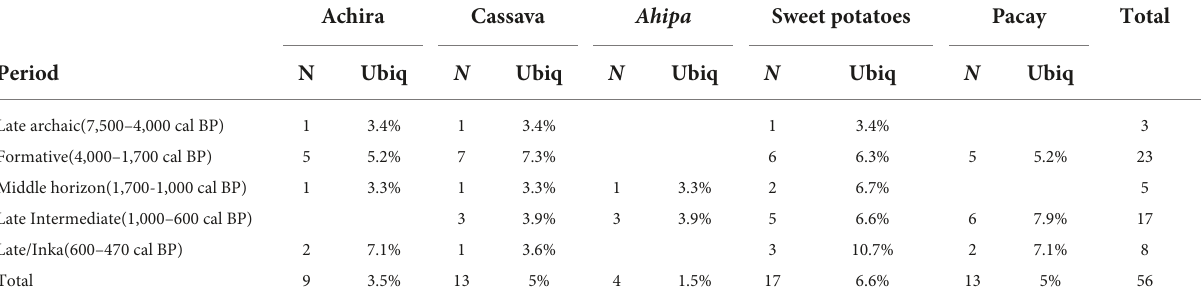
TABLE 1 Presence of crops in number of sites (N) from the Atacama Desert including ubiquity (Ubiq) represented as percentage of presence per chronological period based on Ugalde et al. (2021; Supplementary Table 1